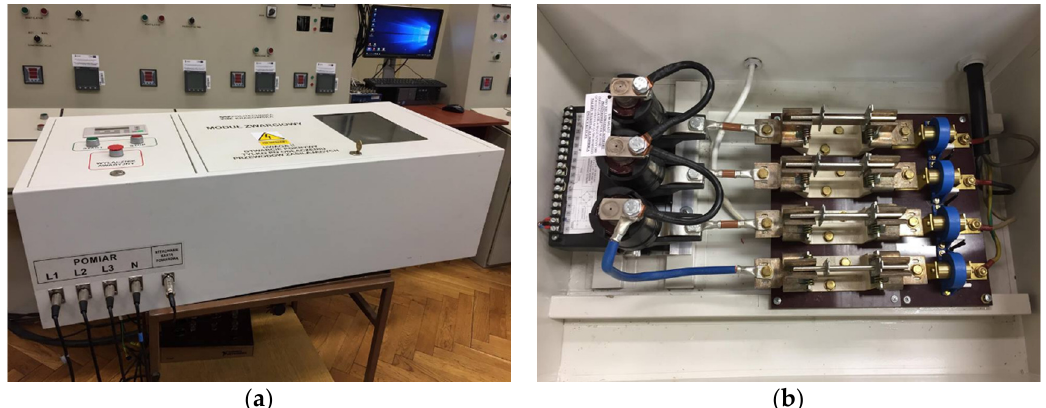
Figure 1. Tested generator with modified excitation system and driving DC machine. Energies 2020 , 13 , x FOR PEER REVIEW